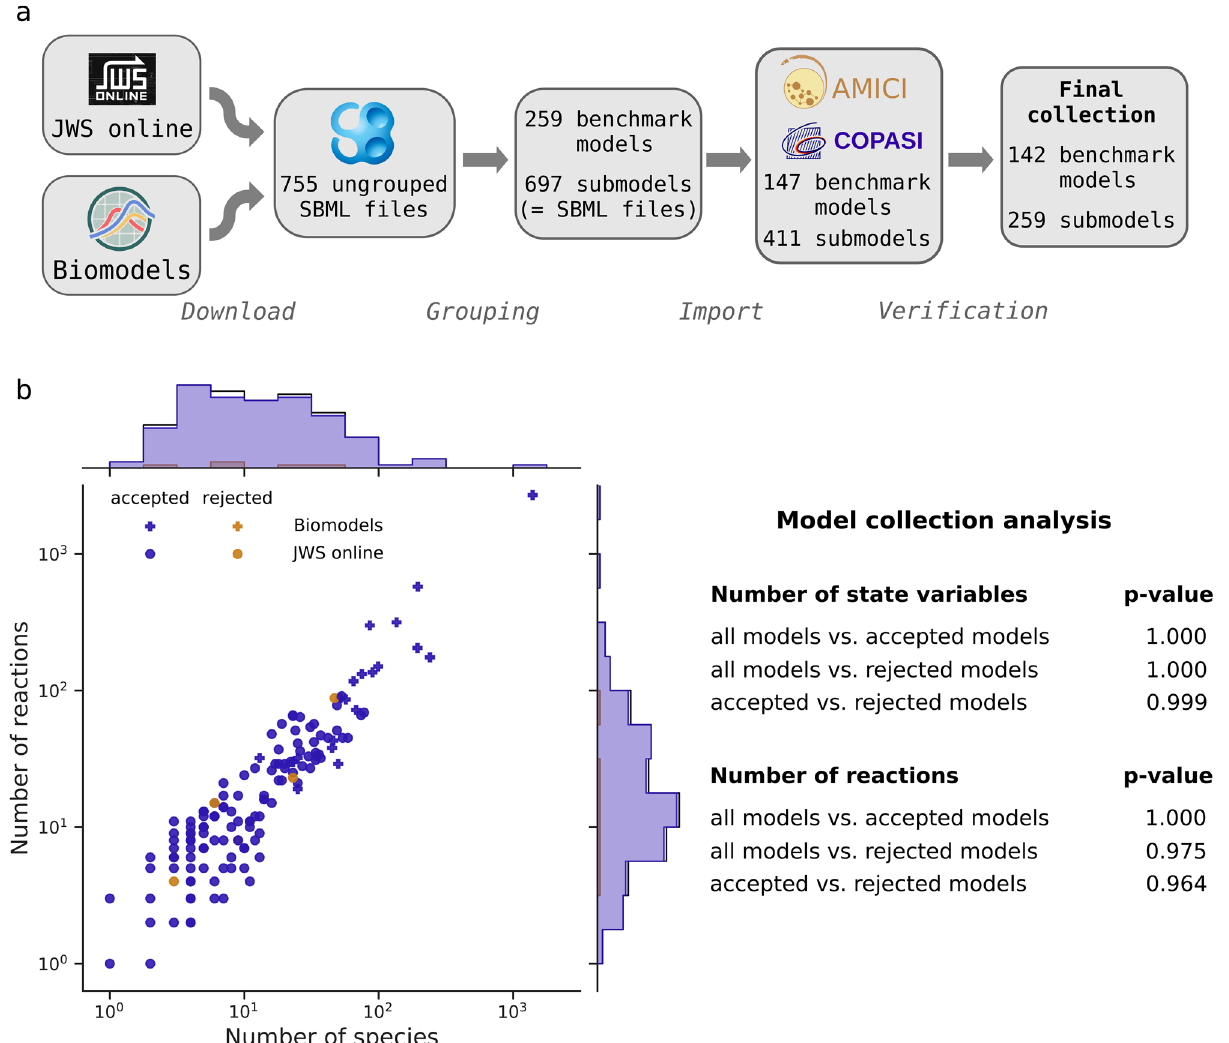
Figure 1. Model collection. ( a ) Workflow of collecting models for the benchmark collection. Models were downloaded, grouped according to their number of species and reactions, the author name and year of their publication, imported with AMICI and COPASI, and simulation results were compared to reference trajectories using multiple solver settings. ( b ) Basic properties (number of state variables and reactions) of the benchmark collection models, as joint scatter plot, indicating the number of accepted, rejected, and the total number of grouped models. The distributions of the numbers of state variables and numbers of reactions were compared for all imported models, vs. accepted models vs. rejected models by a Kolmogorov-Smirnov test, to assess a possible bias due to the filtering